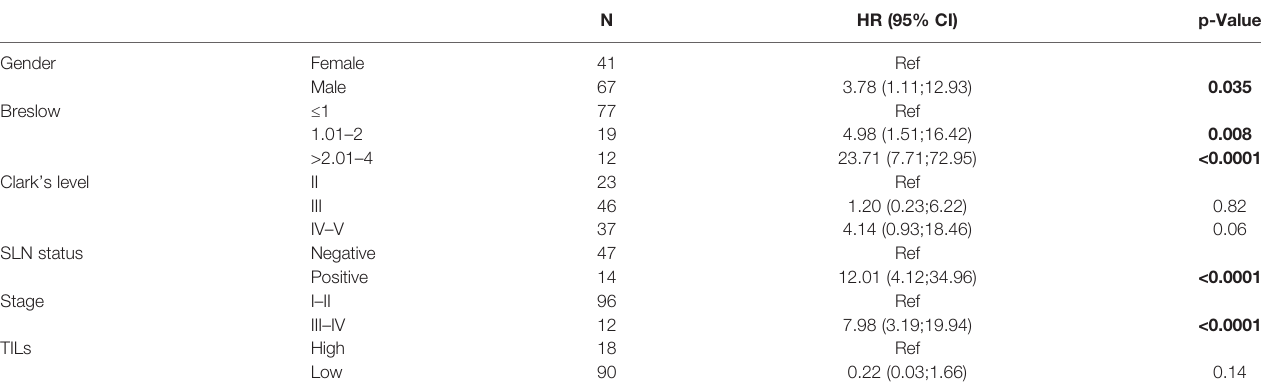
N, Number of patients; HR, Hazard Ratio; CI, con fi dence interval. Bold values correspond to signi fi cant